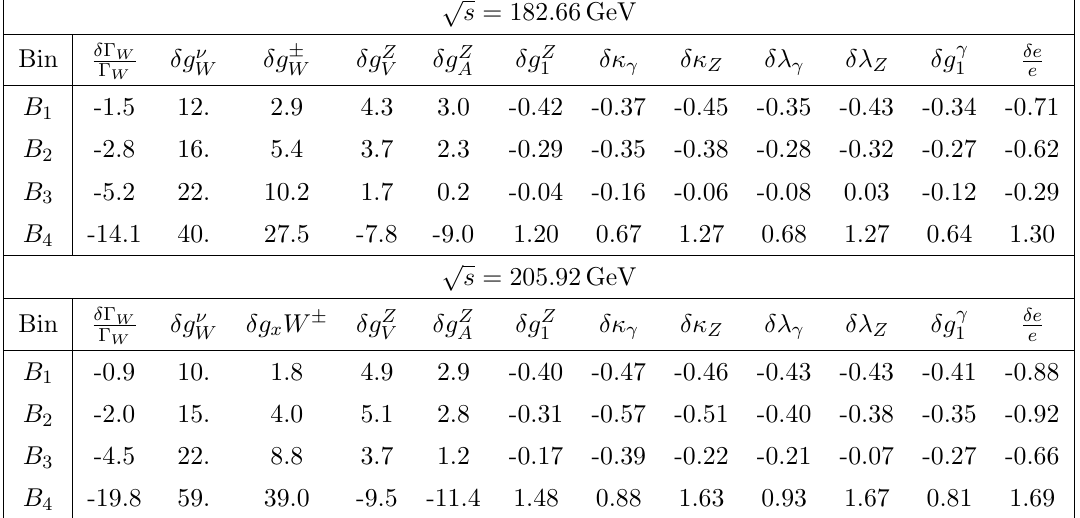
Table 4 . Angular bin cross section contributions (in pb) to (cid:22)